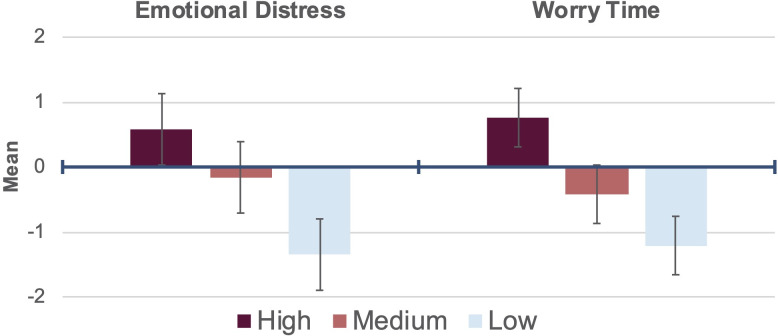
COVID-19 psychological impact profiles derived from z-scores of eight items reduced to two factors using data from college students across the United States (n = 2,534).Means and standard errors shown.